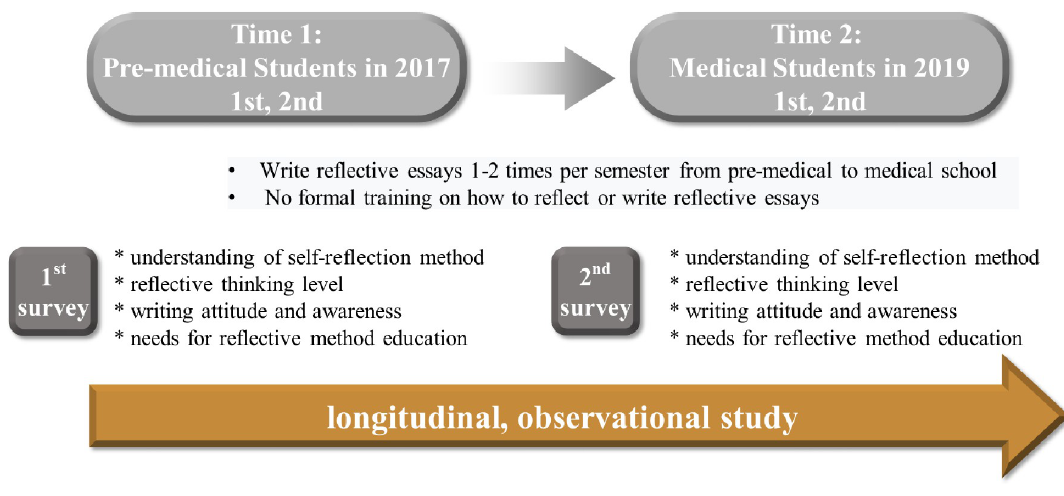
Fig 1. Research design.